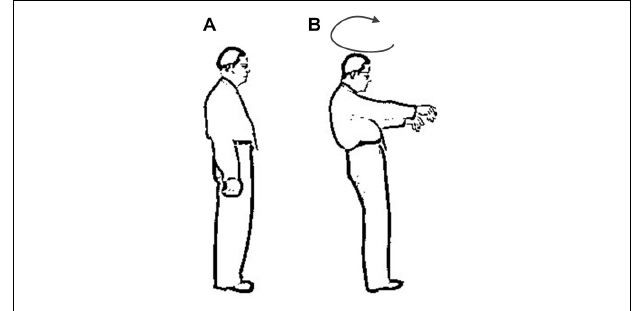
FIGURE 1 | Comparison of different performance of patients with sensory ataxia in Romberg’s test. (A) Eye opening stage and (B) eye closure stage.